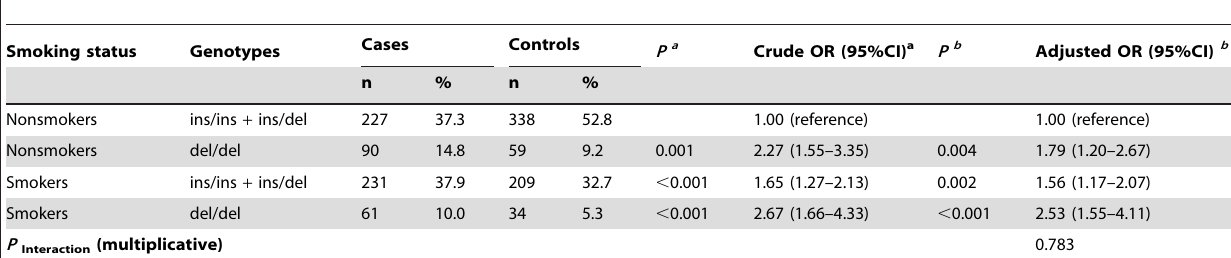
Table 6. Interaction analyses of the NFKB1 promoter –94 ins/del ATTG polymorphism and tobacco smoking.